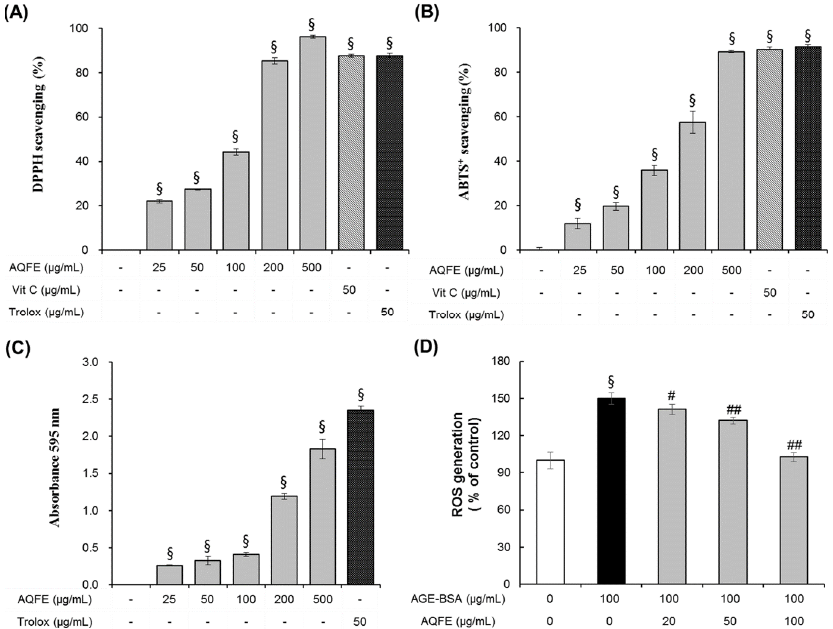
Figure 4. The antioxidant properties of AQFE. Radical scavenging activity was determined by using different concentrations of AQFE (25–500 μ g/mL) or vitamin C and trolox through DPPH ( A ) and ABTS + ( B ) assays. The effect of AQFE was confirmed by measurement of reducing capacity ( C ). Effect of AQFE on intracellular ROS production in AGE ‐ BSA treated human dermal fibroblast cells ( D ). Data are mean ± standard deviation. § p < 0.01 compared with the vehicle ‐ treated group, # p < 0.05 compared with the AGE ‐ BSA treated group, ## p < 0.01 compared with the AGE ‐ BSA treated group ( n = 5). The results were confirmed by eight independent